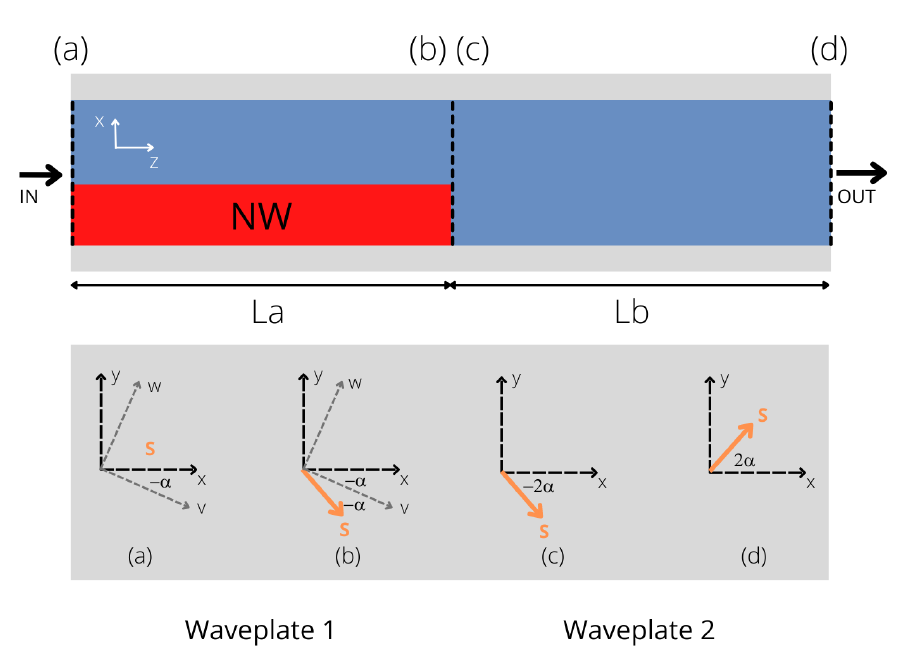
Figure 2. Schematic representation of polarization rotation via halfwave plate asymmetric waveguide subsequent operations. x, y are the waveguide principal axis when no asymmetry is introduced; v, w represent the waveguide axis when the NW is placed; S is the polarization of a linearly polarized propagating